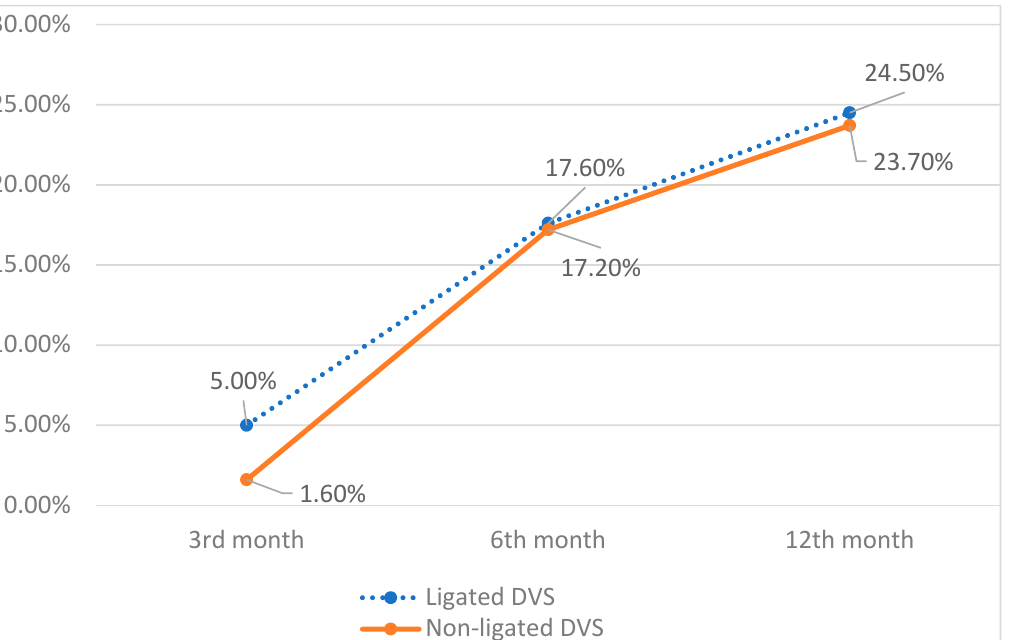
Figure 1. Continence recovery in 12 months follow up.